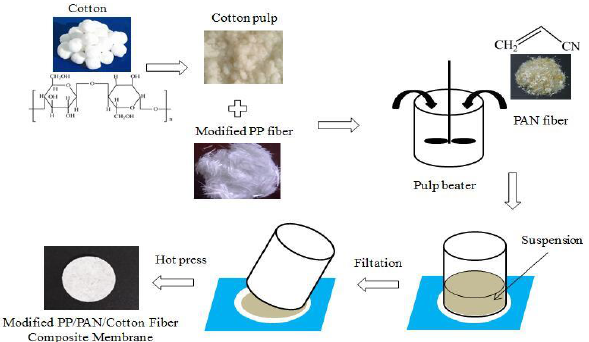
Figure 1. The process for modified PP/PAN/cotton fibers composite membrane.